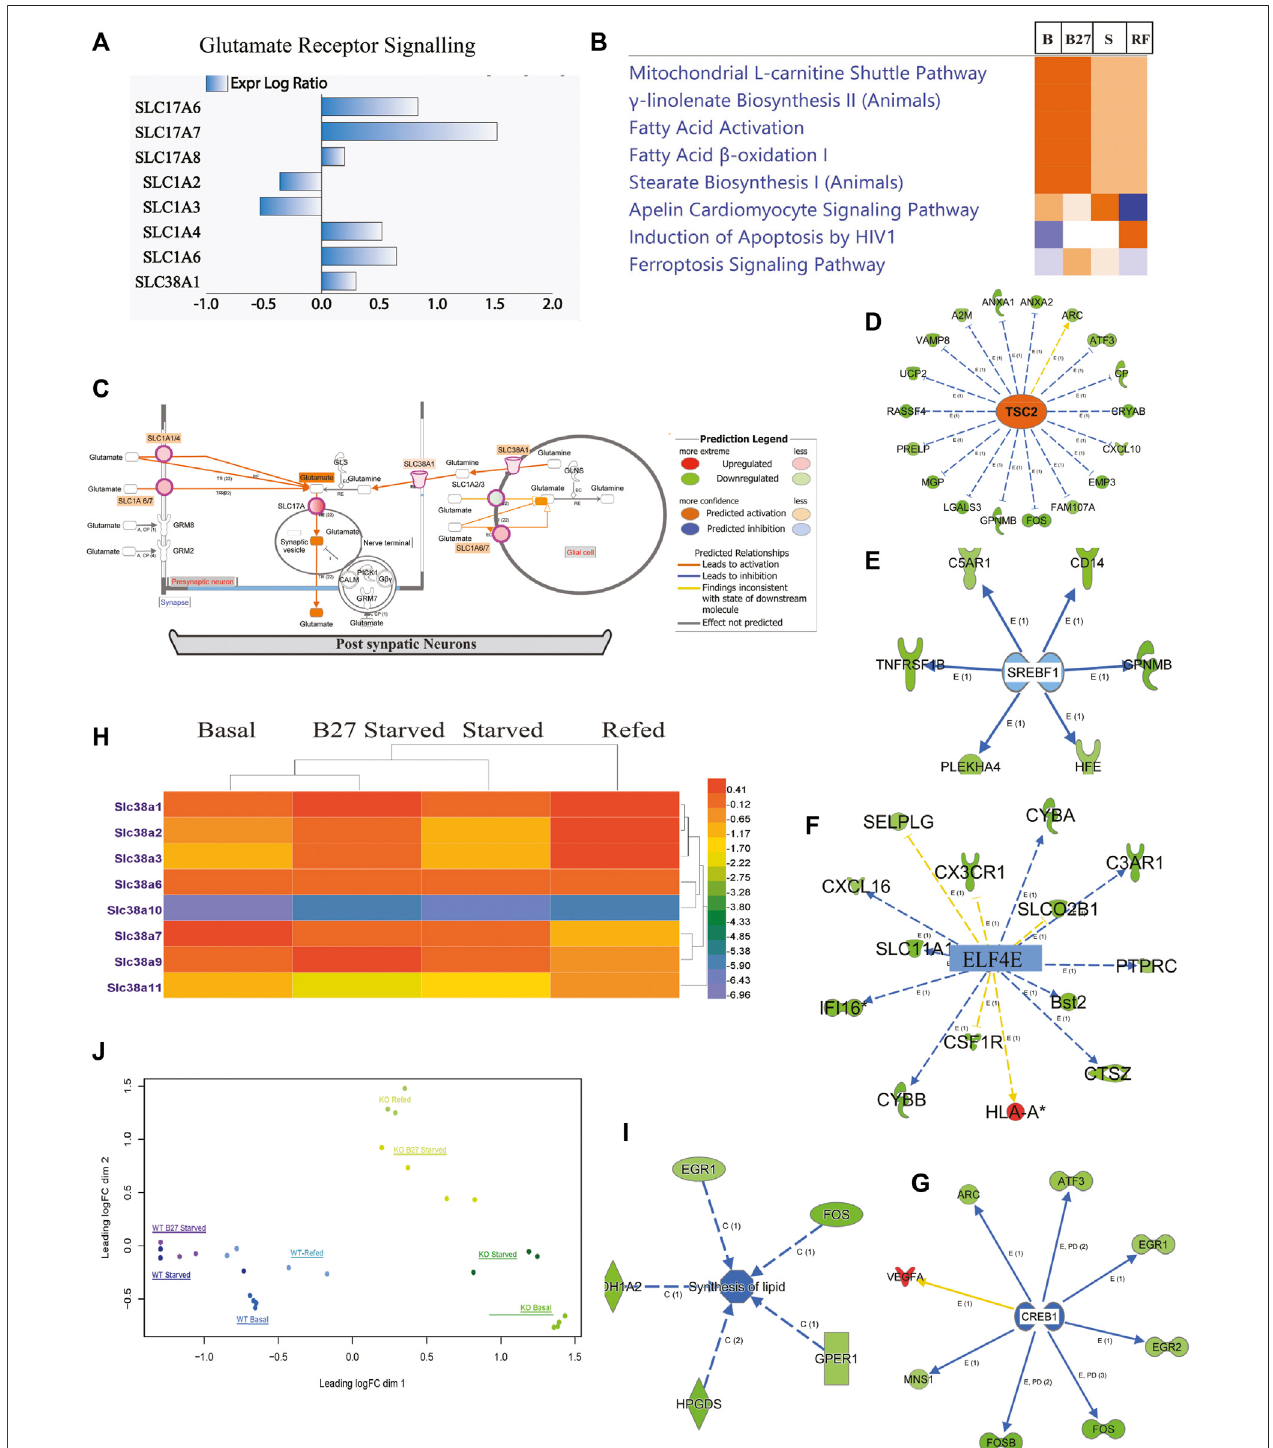
FIGURE 4 | Expression of genes involved in amino acid transport, fatty acid synthesis, and glutamate receptor signaling in KO PCCs. At basal, starved, and refed conditions. Solute carrier transporters changed at basal (B) , starved (S), and refed (R) condi-tions separately, analyzed by IPA software. KO vs . WT fold change using pathway analysis IPA software. Cut-off values were selected as minimum two-fold downregulated or upregulated ( − 2 < FC > 2, adjusted p -value < 0.05) in the KO com- pared to WT cells. (A) Solute carrier transporter transcripts changed, involved in glutamate receptor signaling. (B) Comparison analysis of changed expression of SLCs gene at basal (B) , overnight B27 starved (B27); amino acid starved for 2 h (S), and amino acid refeeding for 1 h (RF). (C) Representation of glutamate receptor